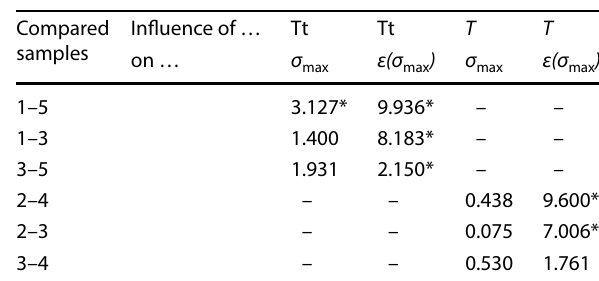
Table 8 Statistical t -values of Student’s t tests on the influence of yarn count and twist on tensile strength as well as elongation at maximum stress of yarn samples